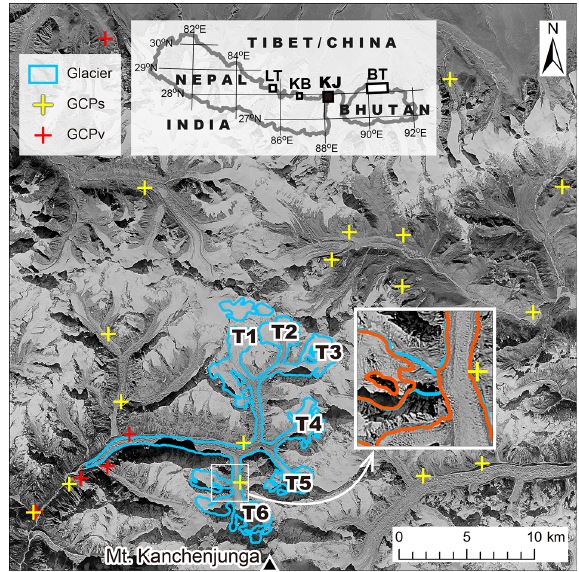
Figure 1. Outline of Kanchenjunga Glacier (blue), with 21 ground control points (GCPs), shown on a Hexagon KH-9 image taken in 1975. Five of the 21 GCPs were used to validate the accuracy of the transformation (GCPv). The major tributaries of Kanchenjunga Glacier are labeled T1 to T6. The inset map shows the location of Kanchenjunga Glacier (KJ, black box), as well as other glaciers (open boxes) in the Langtang region (LT), Khumbu region (KB), and Bhutan (BT), which were compared to this study (Fig. 7). The inset panel provides an example of the change in the glacier outline between 1975 (blue) and 2010